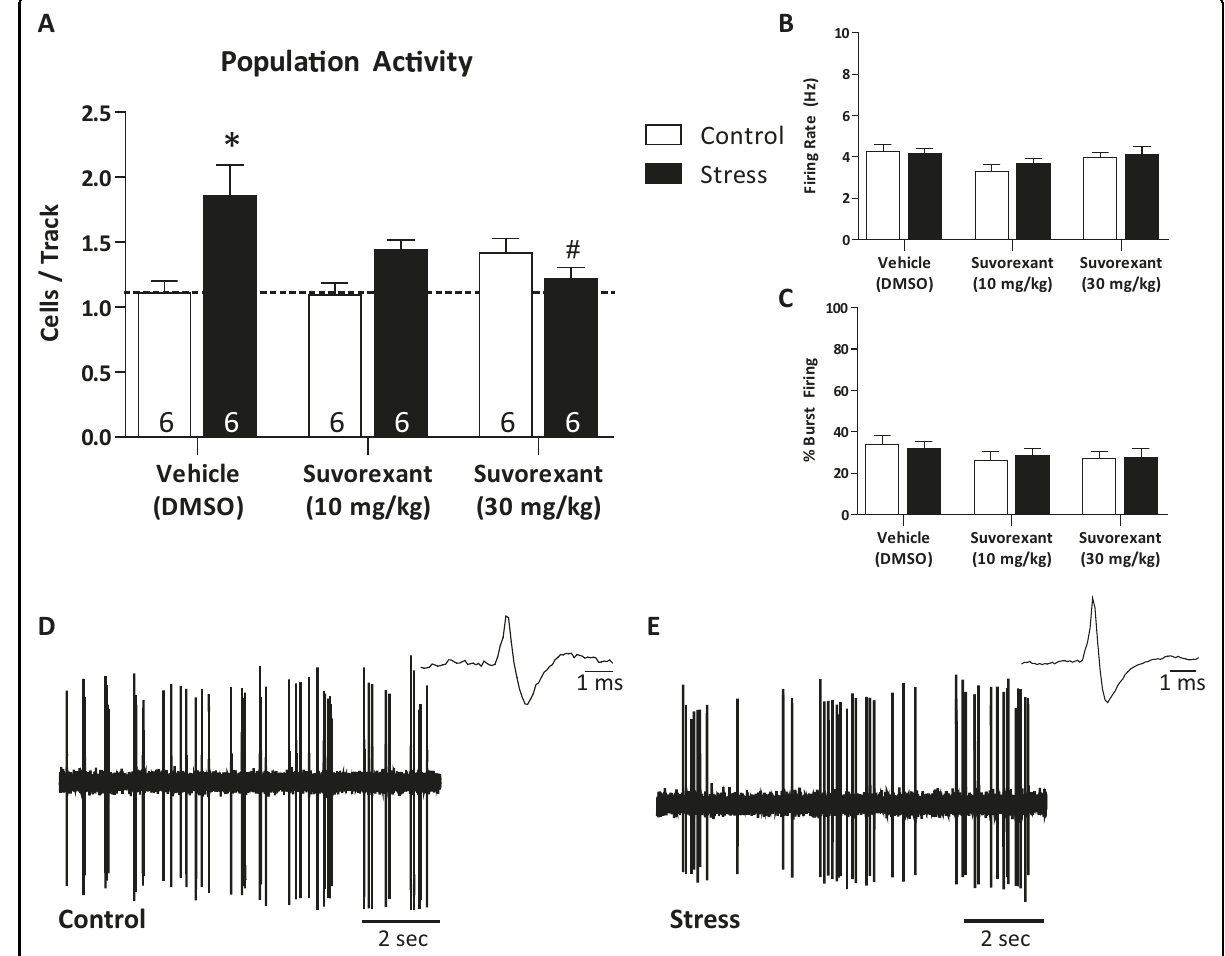
Fig. 1 Suvorexant reverses increased dopamine neuron population activity observed after two-day inescapable foot-shock. Three parameters of dopamine neuron activity were measured: a population activity (average number of spontaneously active dopamine neurons per electrode track), b average fi ring rate, and c average percentage of spikes fi ring in a burst. Two-day inescapable stress increases dopamine neuron population activity which is reversed following administration of Suvorexant ( a ): * p < 0.05 compared with control/vehicle; # p < 0.05 compared with stress/vehicle. There were no signi fi cant changes in fi ring rate ( b ) or bursting pattern ( c ). Representative traces from control animals ( d ) and two-day inescapable shock animals ( e ). n = 6 rats per